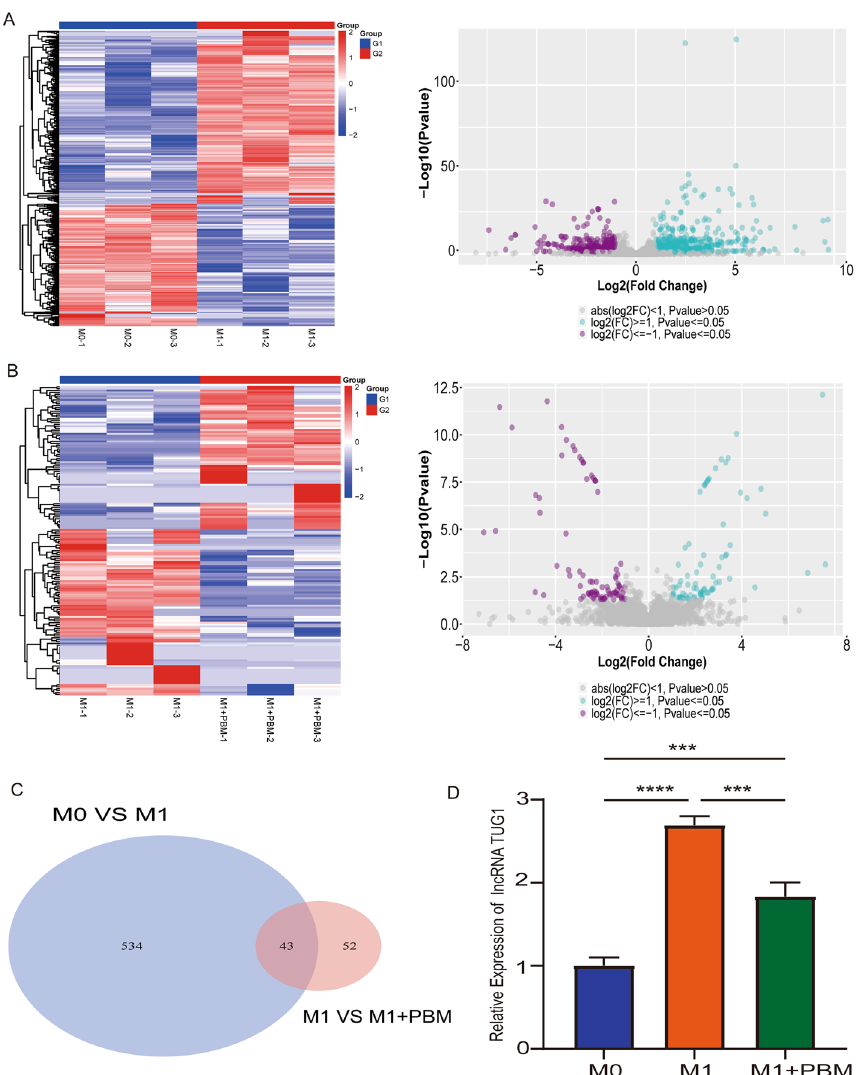
Fig. 2 lncRNA TUG1 as a potential target of PBM. A Differentially expressed lncRNAs in M0 group versus M1 group were presented as heat map and volcano map. B Differentially expressed lncRNAs in M1 group versus M1 PBM group were presented as heat map and volcano map. C Using Venn diagram to present the + difference lncRNAs co-expressed between the two groups (M0 versus M1, M1 versus M1 PBM). D RT-PCR + was used to detect the expression of lncRNA TUG1. n 3 per group. *** P < 0. 001, **** P < =